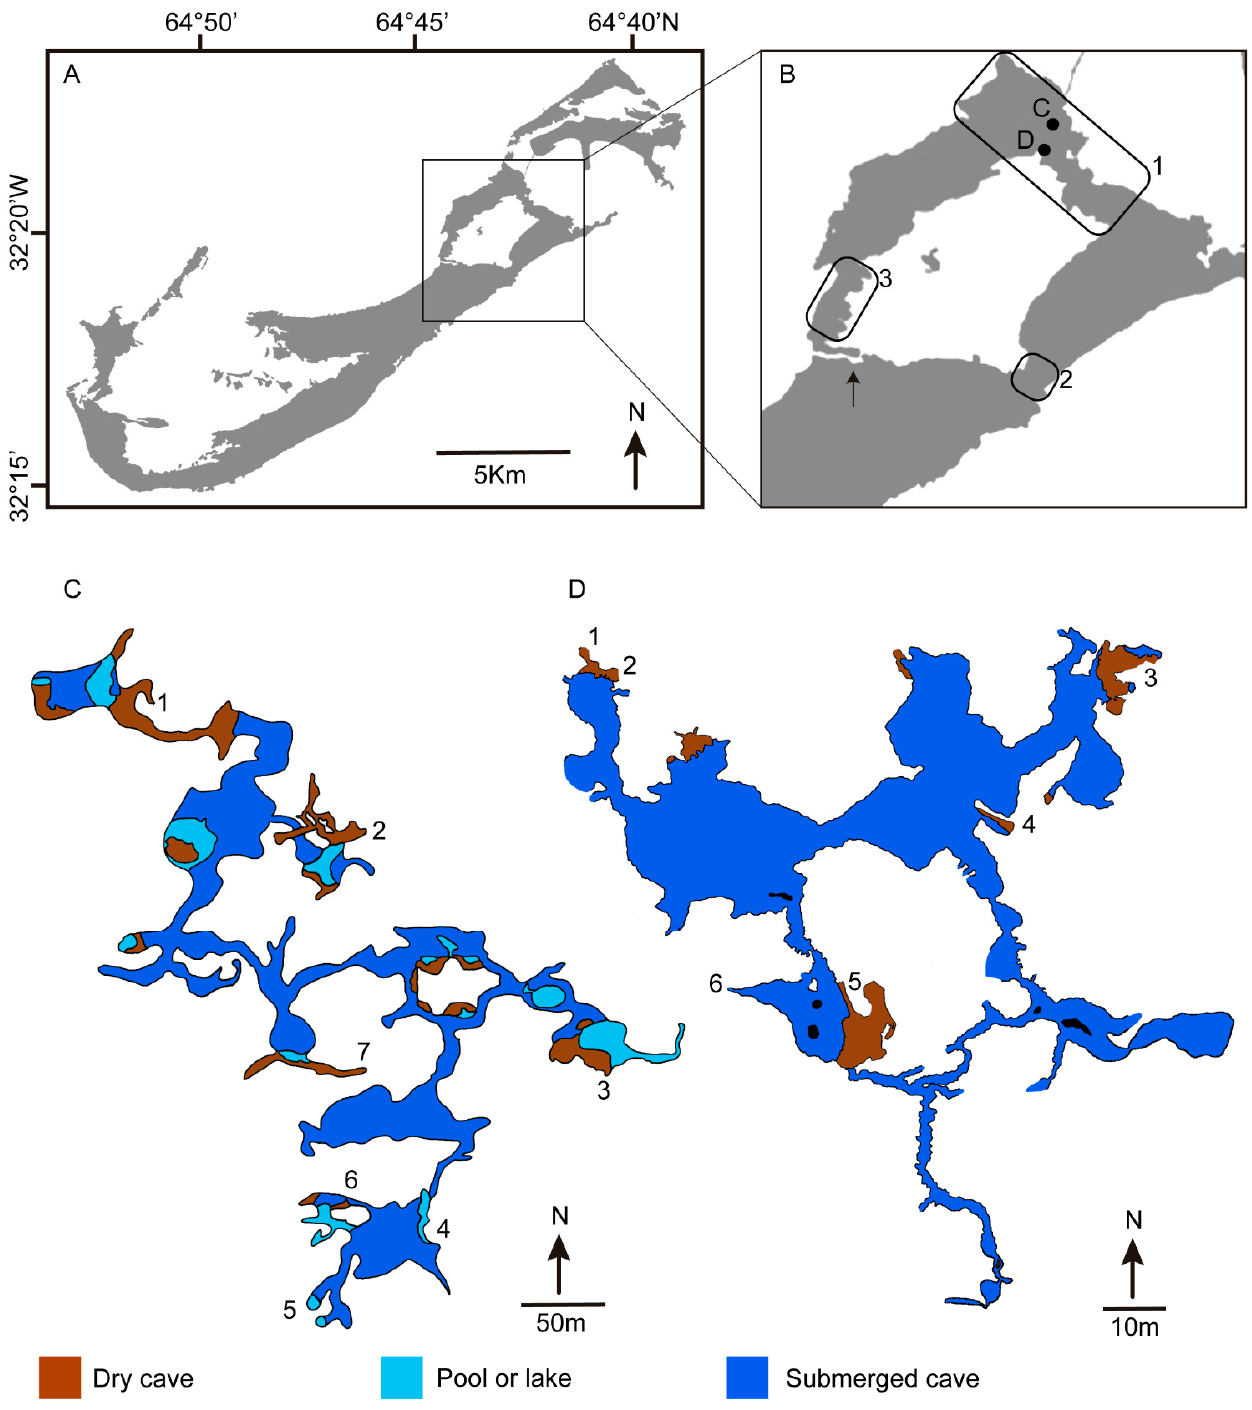
Figure 1. ( A ) Map of Bermuda in the North Atlantic Ocean, ( B ) Cave regions surrounding Harrington Sound, a large inland body of water mostly encircled by land. The arrow indicates the only opening to the sea at Flatt’s Inlet, rectangles show regions of cave and karst development in (1) the Walsingham Tract (with the letters C and D indicating the location of the two main caves), (2) Devil’s Hole, (3) Shelly Bay, ( C ) Walsingham Cave System with cave entrances: (1) Wonderland, (2) Crystal, (3) Walsingham, (4) Deep Blue, (5) Vine, (6) Old Horse, (7) Fern Sink (modified from map by Robert Power), ( D ) Palm Cave System with cave entrances: (1) Palm Slit, (2) Palm, (3) Strawmarket, (4) Sailor’s Choice, (5) Myrtle Bank, (6) Cripple Gate (modified from map by Jason Richards).